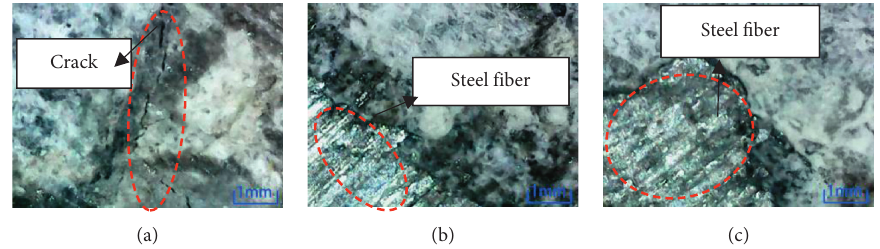
Figure 25: Microscopic observation of specimen soaked in NaCl solution at position 2. (a) 0%. (b) 1%. (c)